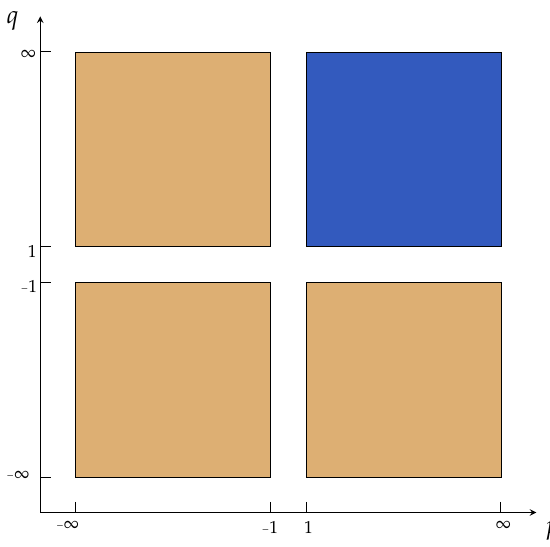
Figure 2. According to Corollary 1, when acting on disjoint subsets, ∆ p , q behaves as a proper metric if ( p , q ) lies in the blue sector, and according to Corollary 2, it behaves like an inframetric if ( p , q ) lies in the orange